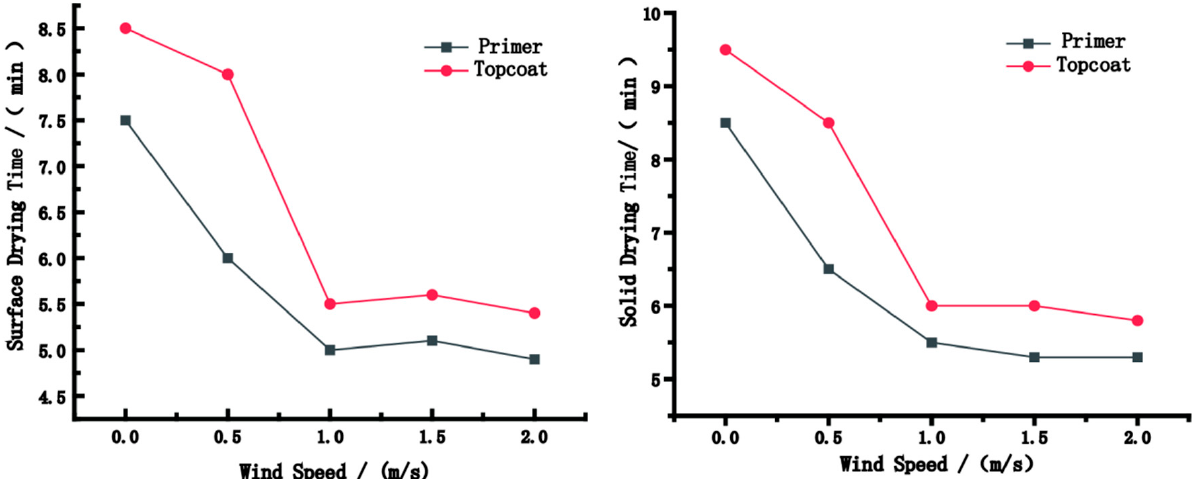
Figure 4. The surface and solid drying time of the paint films under different wind speeds.